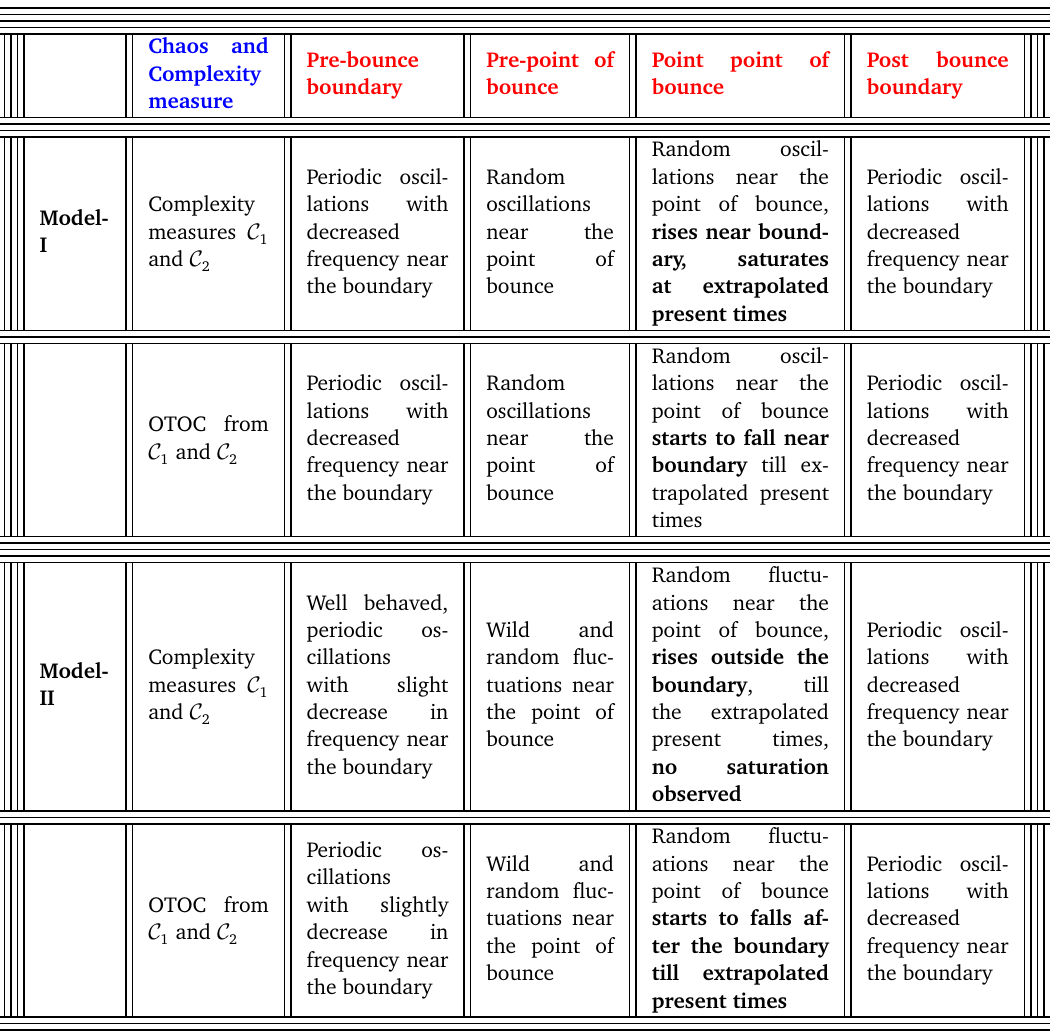
Table 9: Behaviour of the cosmological complexity measures and cosmological OTOC in different region of interest for the two models of bouncing